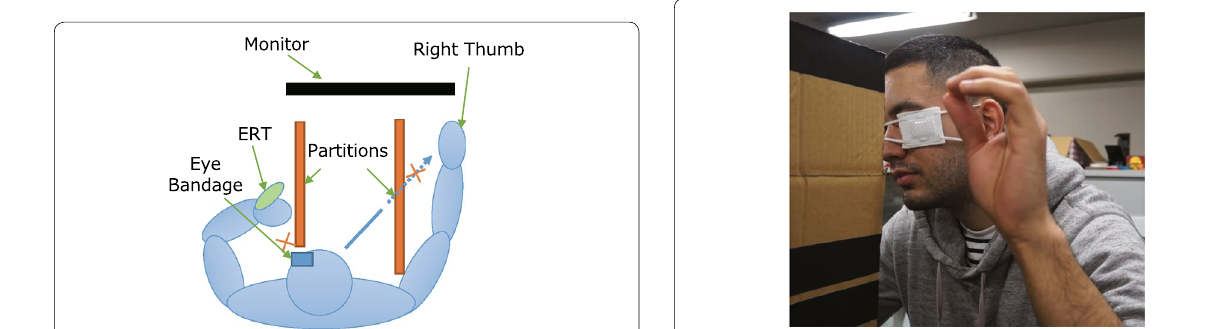
Fig. 6 Reaching task by own finger. The subject uses his own left thumb to touch the targeted